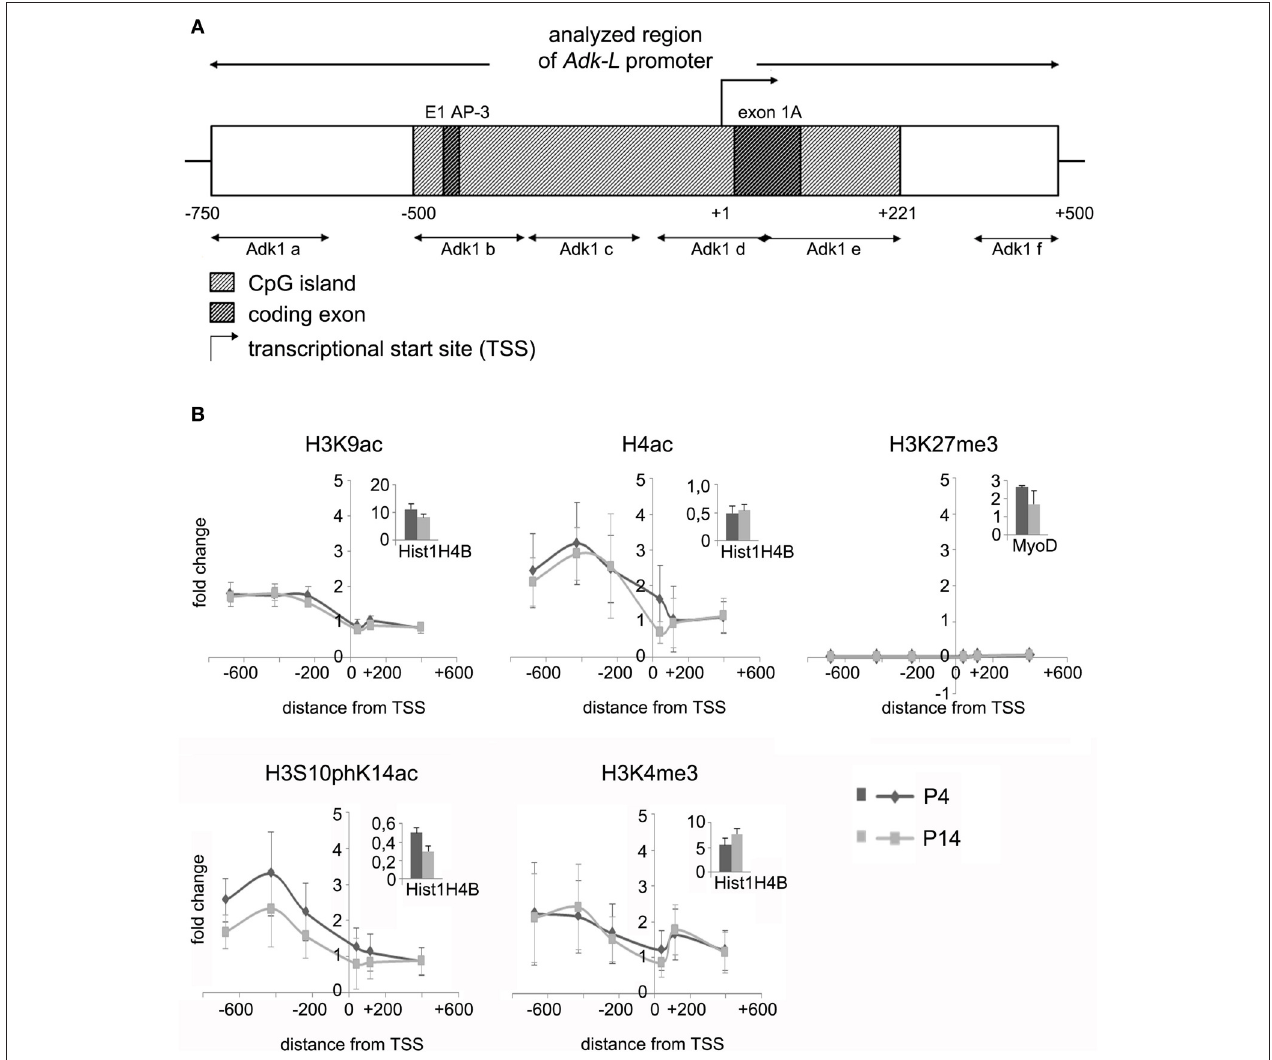
FIGURE 2 | Impact of epigenetic chromatin modifications on Adk-L promoter activity in P4 and P14 rat hippocampal neurons. (A) Promoter region of the long Adk isoform was analyzed from pos. − 735 to + 470 relative to the TSS. (B) Activating histone modifications were identified at the Adk-L promoter in both P4 and P14 hippocampal neurons, including acetylation of H3 and H4, as well as H3 phosphoacetylation and lysine 4 trimethylation, with a relative sparing of the TSS. There was no evidence for repressive H3K27 trimethylation. Upper right corner of each diagram with insets showing enrichment of positive controls for each antibody presented as percent of the total input chromatin (% input). Adk-L promoter, promoter regulating long Adk isoform expression; ChIP, chromatin immunoprecipitation; H3K9ac, acetylation of lysine (K) 9 of histone H3; H4ac, pan-acetylation of histone H4; H3S10phK14ac, phosphoacetylation of histone H3 targeting Serine (S) 10 and Lysine (K) 14; H3K4me3, trimethylation of lysine (K) 4 of histone H3; H3K27me3, trimethylation of lysine (K) 27 of histone H3; TSS, transcriptional start